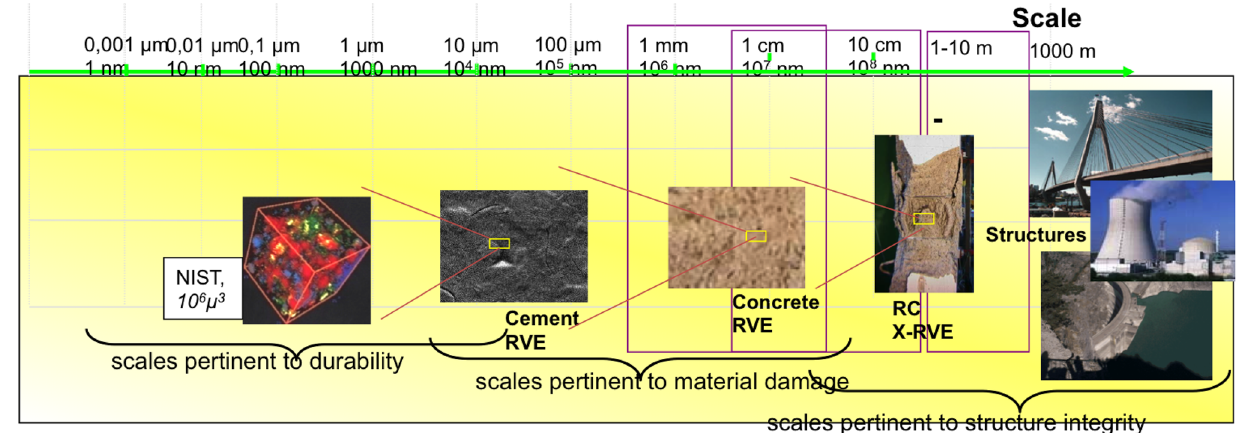
Fig. 2 Concrete composites micro-scale, meso-scale and macro-scale for quantifying durability, damage and